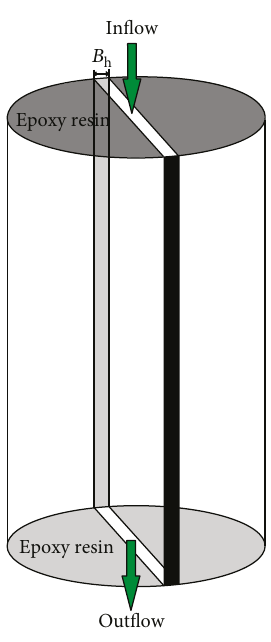
Figure 1: Schematic diagram of the carbonate samples after having been fractured and covered by epoxy